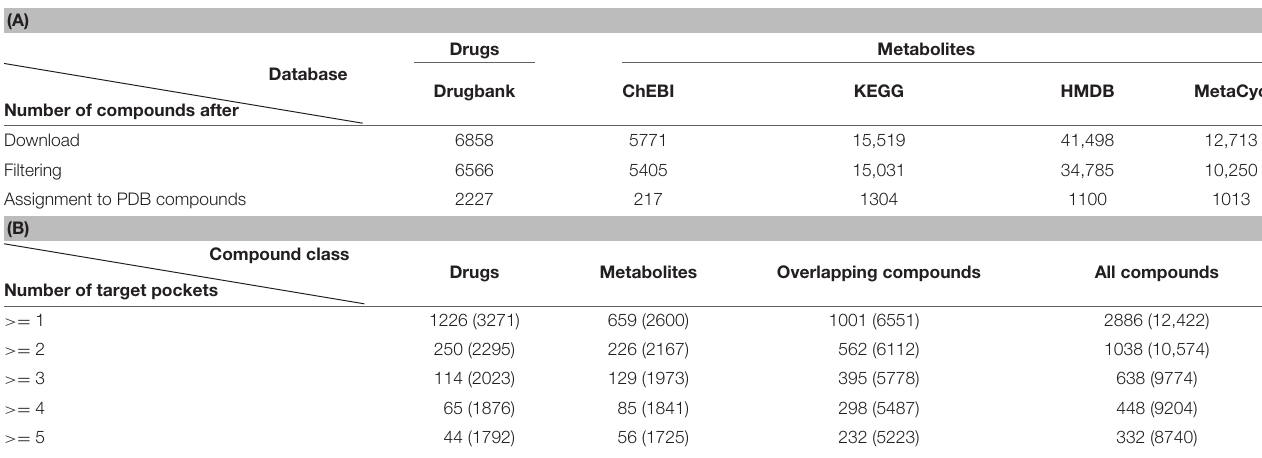
(A) Number of drug and metabolite structures downloaded from DrugBank, ChEBI, KEGG, HMDB, and MetaCyc, filtered according to molecular weights and SMILES computability, and assigned to PDB compounds. (B) Number of PDB compounds categorized as drugs, metabolites or overlapping compounds that are bound to at least 1, 2, etc. non-redundant protein target pockets. The numbers of interacting target pockets are listed in